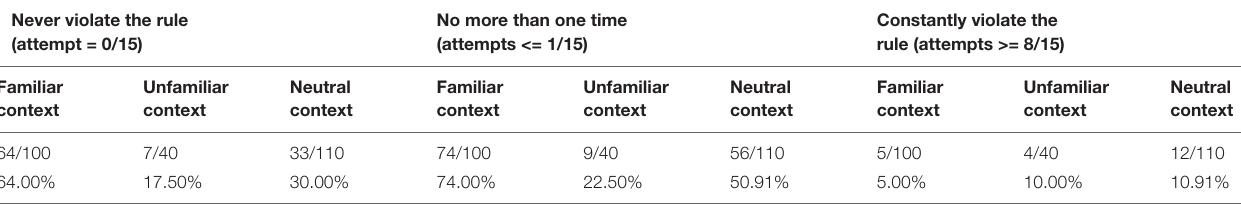
No more than one time (attempts <=